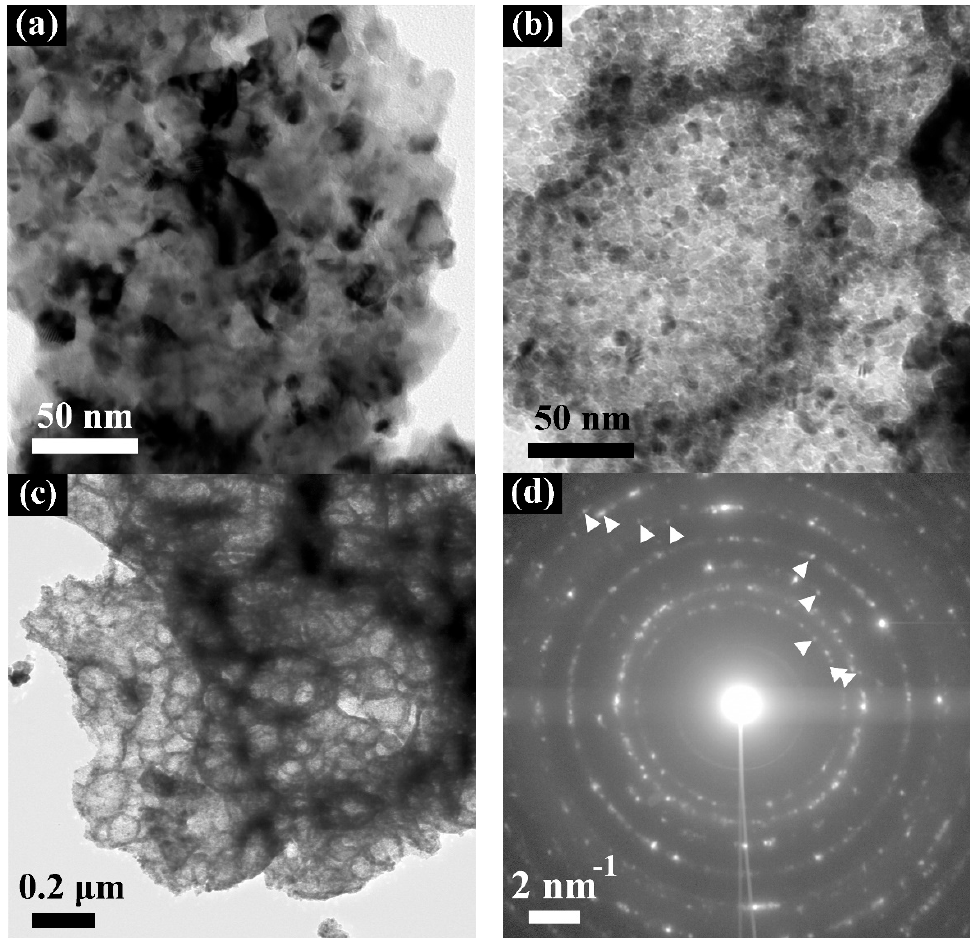
Figure 1. S_29 (100 mL of H 2 O). TEM bright field images of areas exhibiting 15–50 nm crystallites ( a ) and 5–12 nm crystallites ( b ). ( c ) A low-magnification TEM image of area ( b ). A typical selected area electron diffraction (SAED) pattern ( d ).